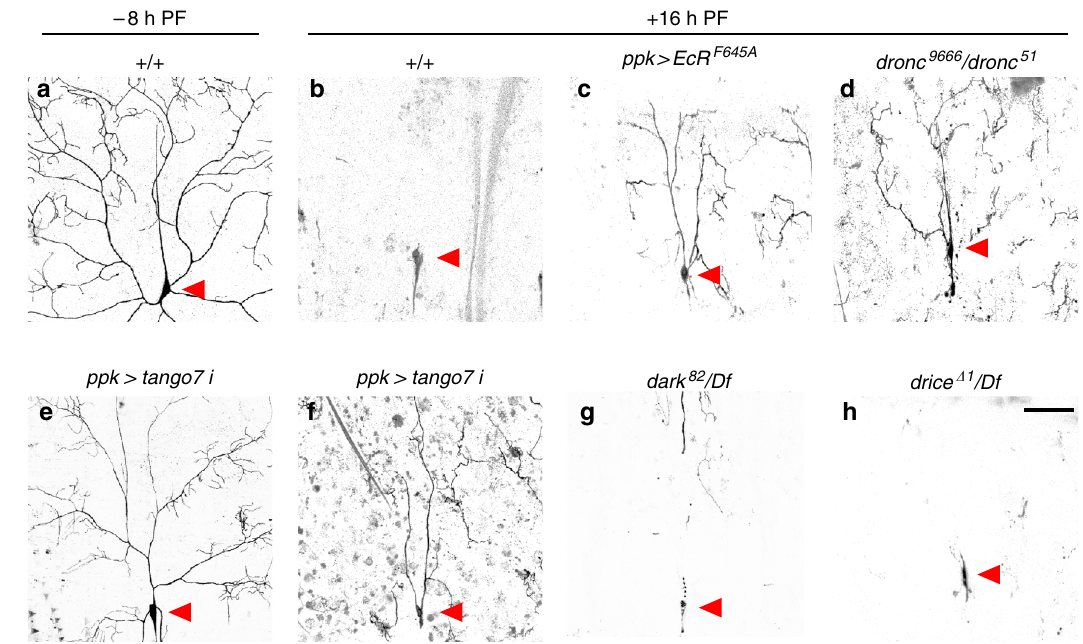
Fig. 5 Caspase-dependent pruning of class IV ddaC dendrites during metamorphosis requires tango7 but not dark . a , b Dendritic arborizations, visualized by ppk-GAL4 -driven expression of GFP, are present at − 8 h PF a , but are completely pruned by + 16 h PF b . c , d Expression of a dominant-negative ecdysone receptor ( EcR F645A ) using ppk-GAL4 ( c ) or mutation of dronc ( d ) disrupts pruning at + 16 h PF. e , f Fewer dendritic arborizations form at − 8 h PF upon RNAi knockdown of tango7 (using ppk-GAL4 ) e ; however, these branches are not properly pruned at + 16 h PF f . g , h Dendritic pruning occurs normally in dark ( g ) or drice ( h ) mutant animals. Red arrowheads indicate the soma of ddaC neurons. Scale bars represent 100 µ m. Df, de fi ciency, PF, puparium